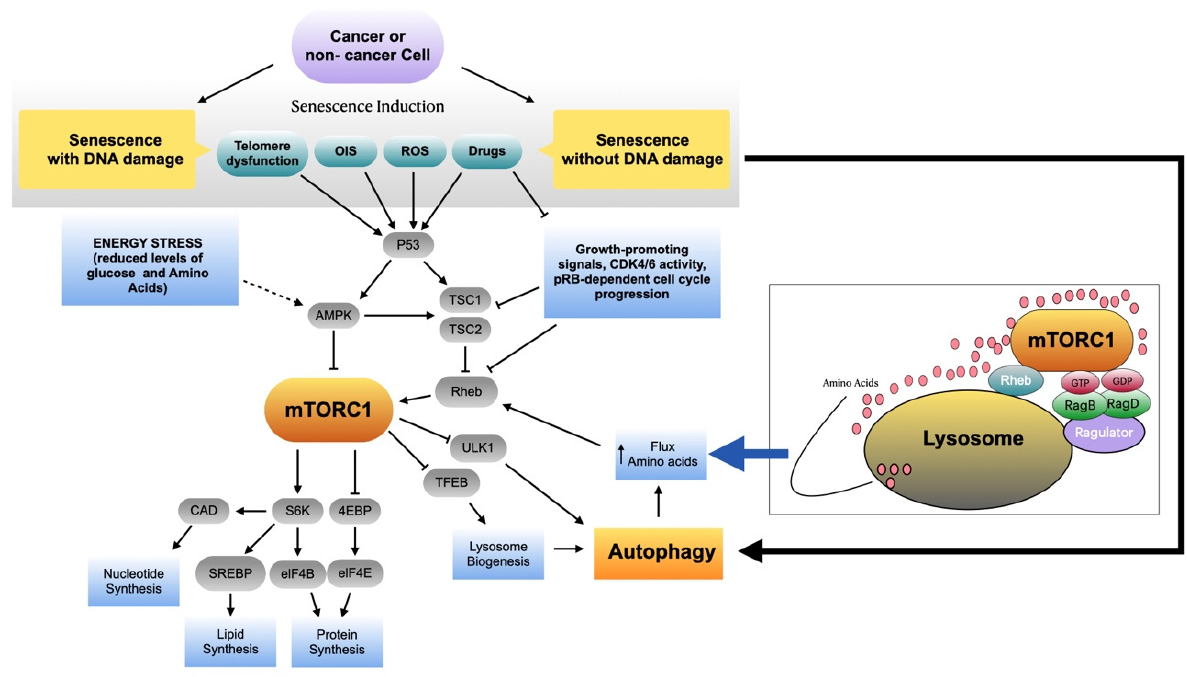
Figure 1. mTORC1 and autophagy as modulators of cellular senescence. Cancer and non-cancer cells can be rendered senescent by different stimuli. Some of these stimuli induce senescence by activating the DNA damage response, while others, including some chemotherapeutic drugs (e.g., CDK4/6 inhibitors), do not seem to require this step to activate the senescence program. It has been shown that p53-dependent responses induce the inhibition of mTORC1 through path- ways that impinge on the tuberous sclerosis complex (TSC1/TSC2) or, indirectly, through activation of AMP-activated protein kinase (AMPK). Similarly, pro-senescence stimuli coursing with absence of DNA damage (e.g., senescence induced by CDK4/6 inhibitors) would be expected to lead to mTORC1 inhibition by relieving Rheb GTPase. As mTORC1 activity is elevated in senescent cells, it is thought that inputs for mTORC1 activation are provided by senescence-associated au- tophagy. By undergoing activation driven by the amino acids released by autophagy-mediated recycling, Rag-GTPases orchestrate the recruitment of mTORC1 to the lysosome membrane, a step that enables the activation of mTORC1 by the lysosomal GTPase Rheb. Known substrates of mTORC1 complexes include the protein S6 kinase (S6K) and the eukaryotic translation initiation factor 4E binding protein (4E-BP). Phosphorylation of these proteins by mTORC1 leads nucleotide synthesis by CAD (carbamoyl-phosphate synthetase 2, aspartate transcarbamylase, and dihydroorotase), lipid synthesis by sterol regulatory element binding protein (SREBP), and protein synthesis by the combined actions of S6K, eIF-4B, and eIF-4E. Notice that, in non-senescent cells, active mTORC1 complexes also inhibit autophagy by blocking the activity of proteins responsible for the initiation of the process (e.g., ULK1) and by sequestering transcription factors needed for lysosomal biogenesis (TFEB). 4. Autophagy in Senescent Cells Autophagy is a highly regulated catabolic process in which cellular components are targeted for lysosome-mediated degradation [130,131]. Basal levels of autophagy serve as a quality control mechanism that prevents the accumulation of protein aggregates and damaged organelles [132]. In metabolically challenged or damaged cells, on the other hand, an increased autophagic flux provides basic metabolic substrates necessary for short-term survival [133]. Under these circumstances, autophagy is thought to maintain the mitochondrial function, the energy balance, and lipid metabolism and also provides substrates that feed metabolic pathways needed for amino acid and nucleotide synthesis [134–137]. At the organismal level, autophagy constitutes an important mechanism of ad- aptation to starvation and metabolic disturbances; it also serves as a mechanism that pre- vents the emergence of neurodegenerative diseases driven by the reduced elimination of misfolded or aggregated proteins [138,139]. Notably, the role of autophagy in cancer ap- pears to be context-dependent [140,141]. While autophagy deficiency may promote tu- morigenesis in some models [142–144], fully transformed cancer cells still depend on au- tophagy to withstand the metabolic stress present in tumor microenvironments [145,146].